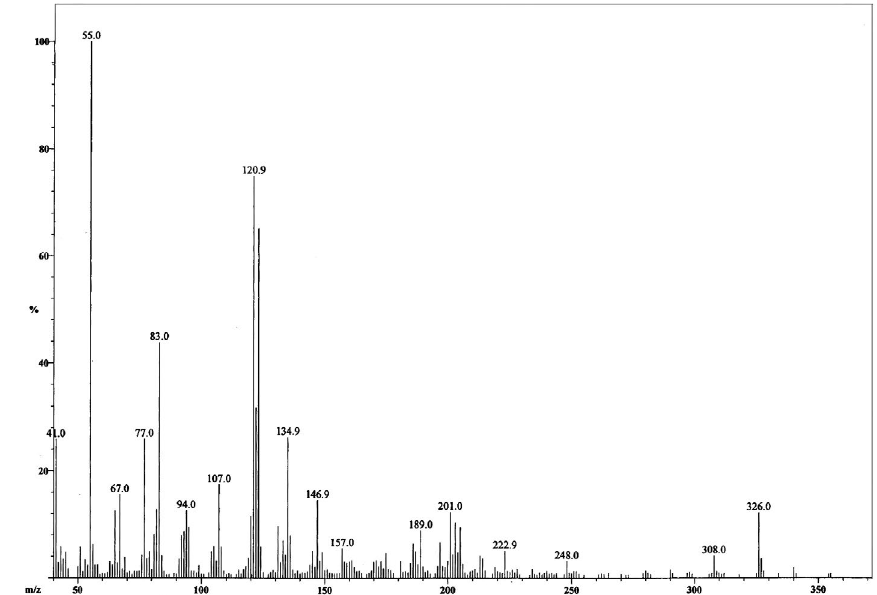
Figure 1 . E.I mass spectrum of the monomer o